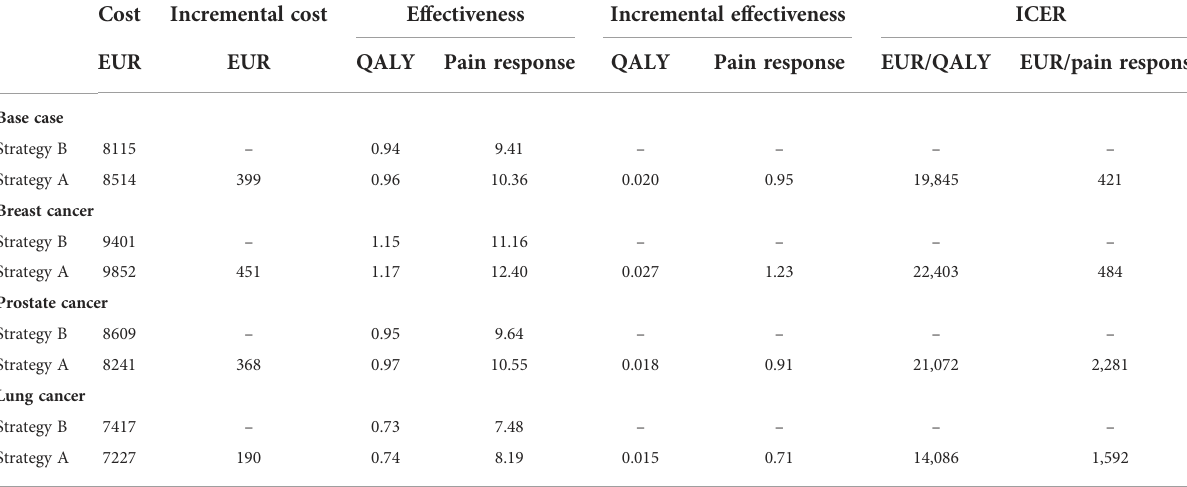
TABLE 2 Base case results and subgroup analyses according to primary